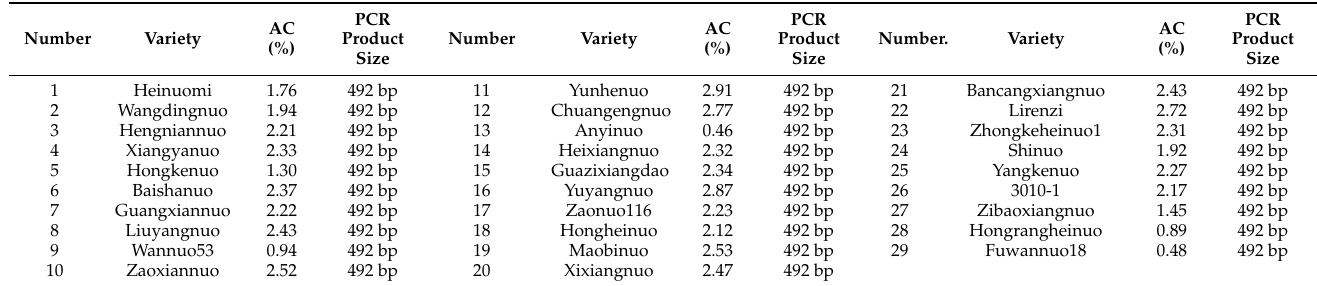
Table 1. Amylose content determination results of the 29 glutinous rice